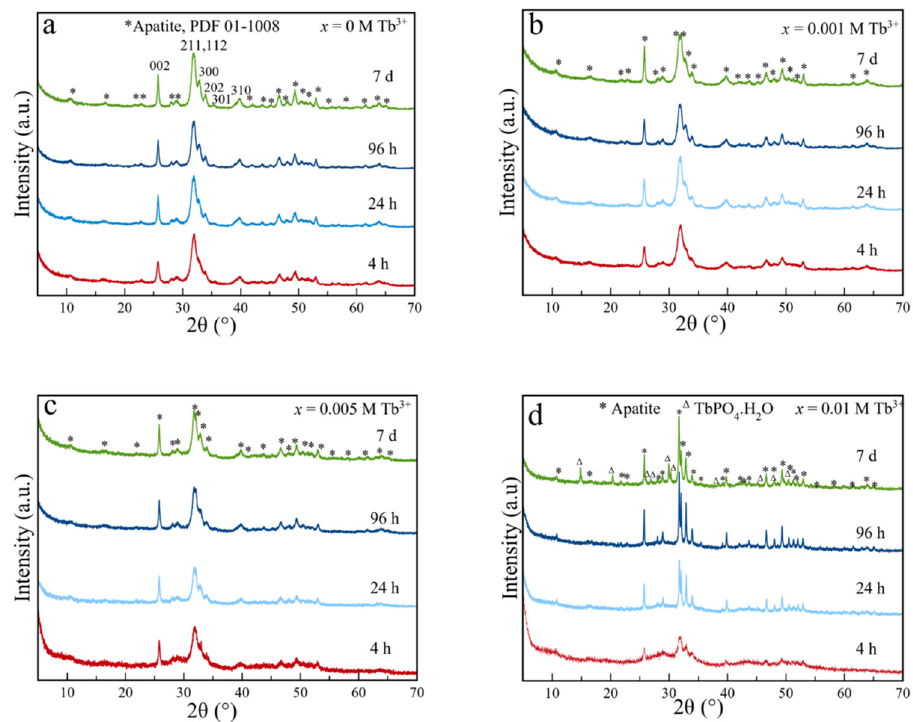
Figure 1. X-ray diffraction patterns of precipitates at 4 h, 24 h, 96 h, and 7 days, and at different x: ( a ) 0, ( b ) 0.001, ( c ) 0.005, and ( d ) 0.010 M Tb 3+ . * (apatite, PDF 01-1008); Δ (TbPO4·H 2 O, PDF 20-1244). For x = 0.010 M Tb 3+ , the evolution is different. At 24 h, the diffractogram presents narrower peaks characteristic of a more crystalline material with larger dimensions